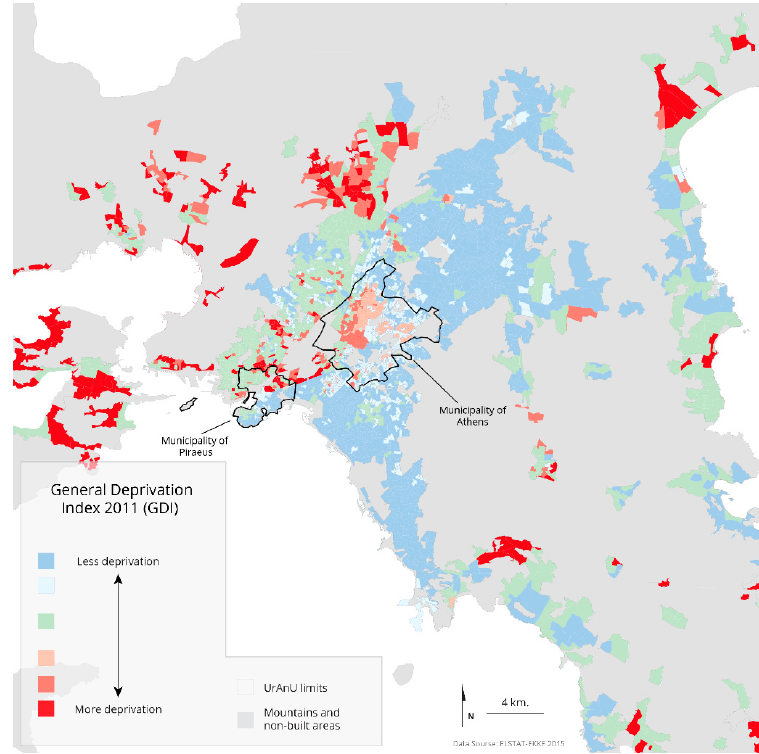
Figure 5. Clusters of deprivation in Athens (2011).